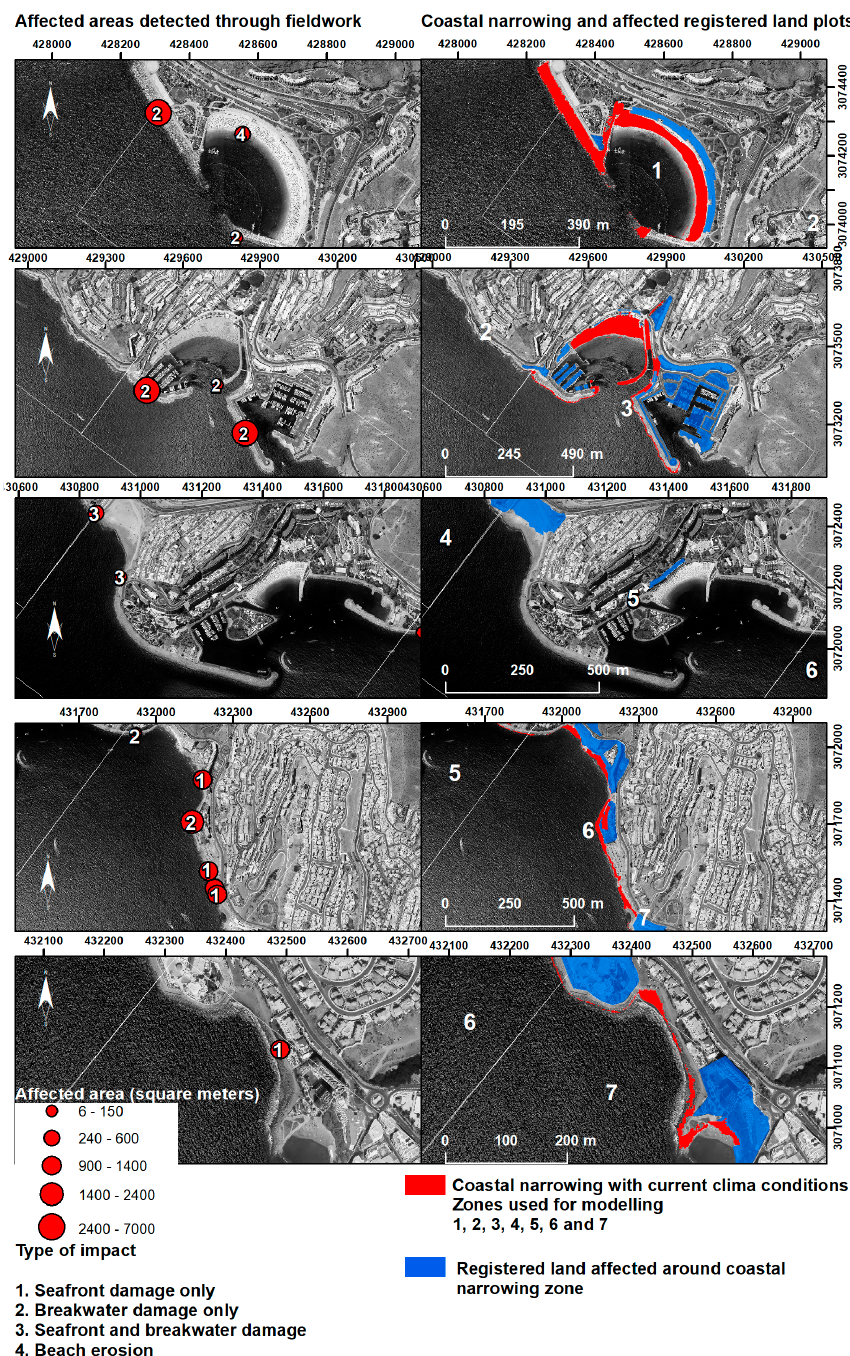
Figure 7. Distribution of the environmental effects identified through fieldwork.